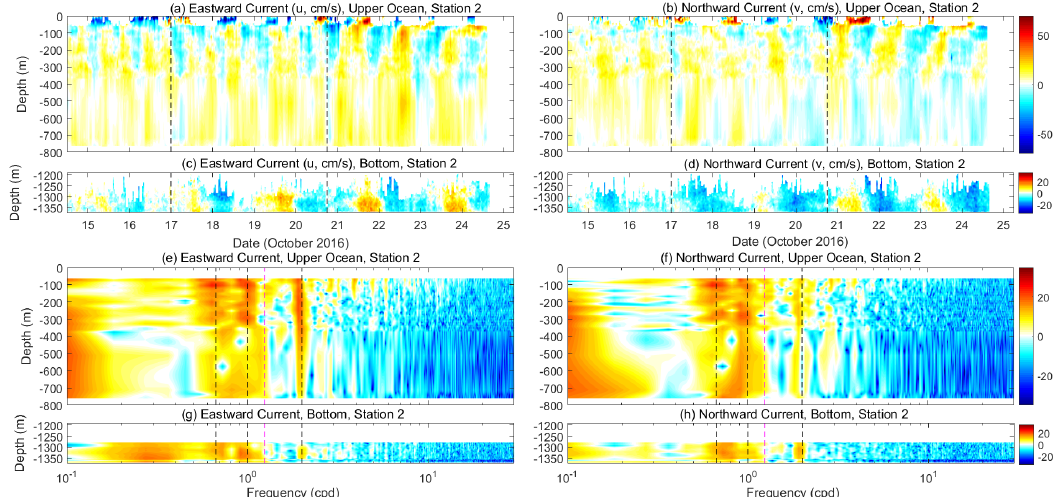
Figure 8. Eastward and northward current ( a – d ) at Station 2, and their spectra between October 13 and 24 ( e – h ). The vertical black dashed lines indicate the inertial, diurnal, and semidiurnal frequencies. The vertical violet dashed lines indicate twice the inertial